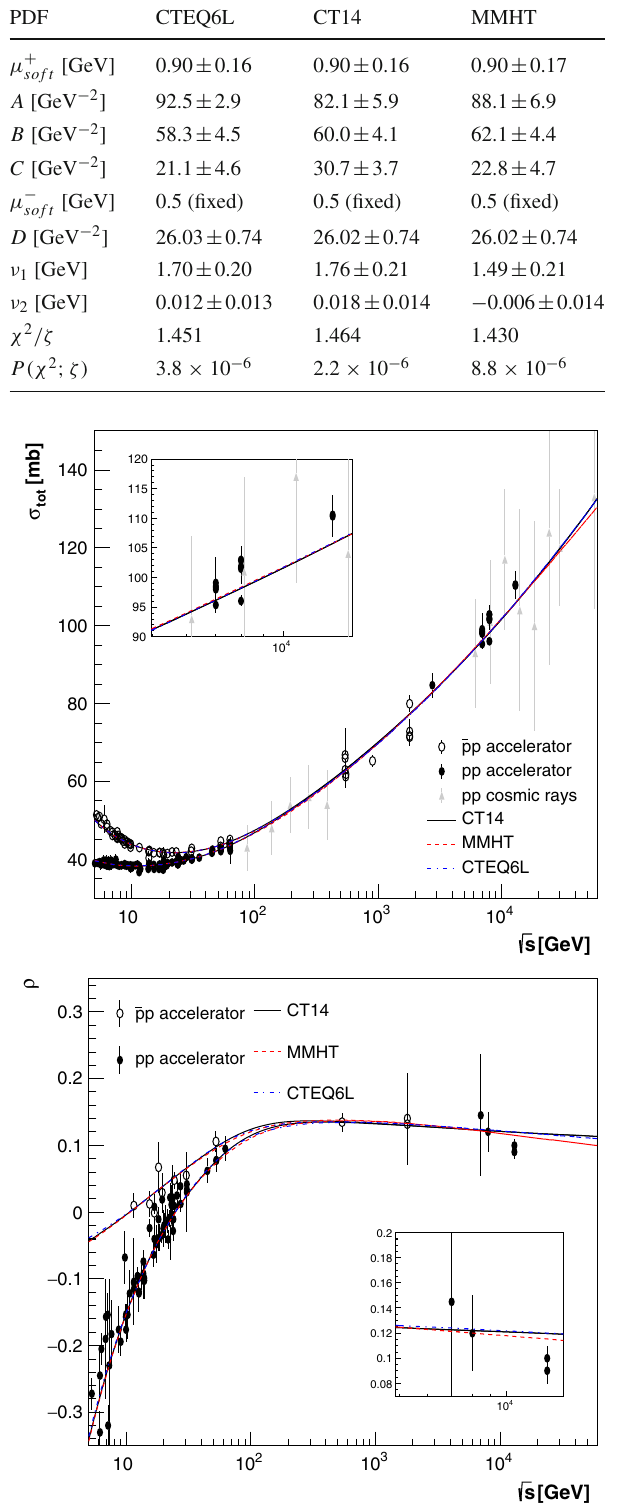
/ ¯ pp ρ pp / ¯ pp data for low-energy cutoff tot and